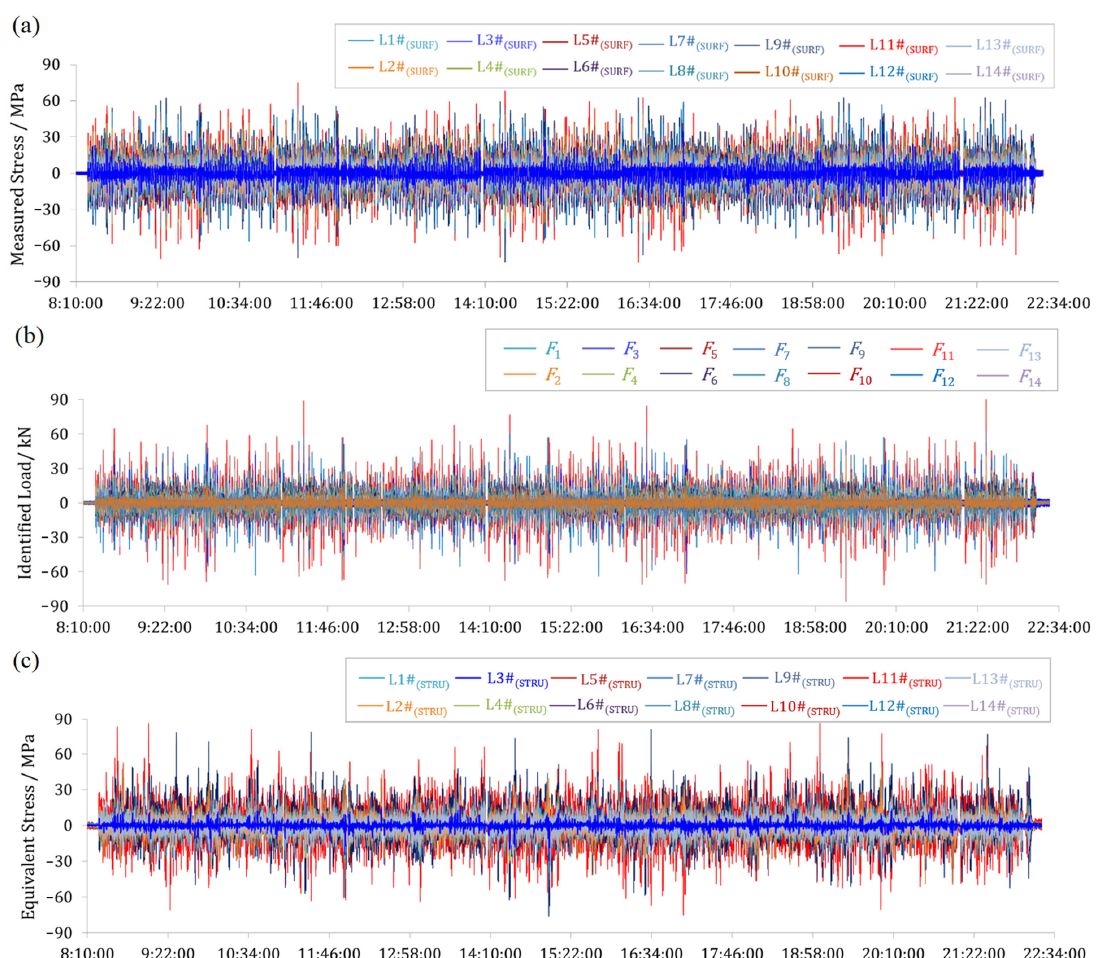
Figure 12. Time - history curves. ( a ) Measured stress; ( b ) identified load; ( c ) reconstructed stress.